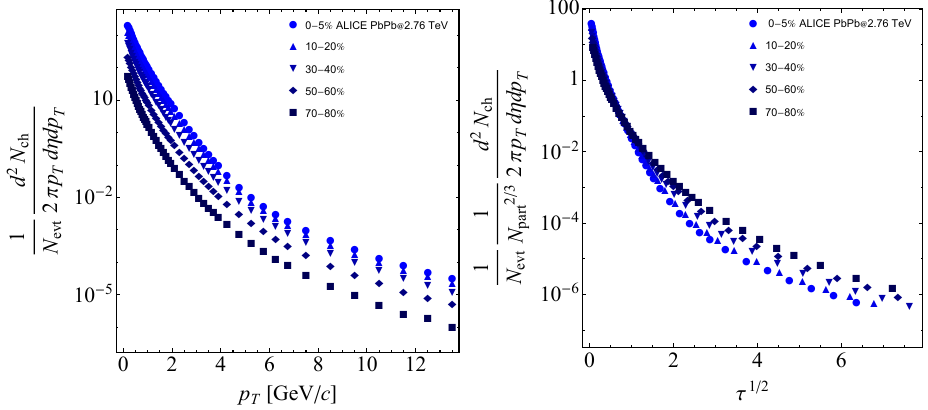
Figure 3. Illustration of geometrical scaling in heavy ion collisions at fixed ALICE [14] energy of 2.76 TeV for di (cid:11) erent centrality classes. Left panel shows charge particle distributions plotted as functions of p T . In the right panel the same distributions are scaled according to Eq.